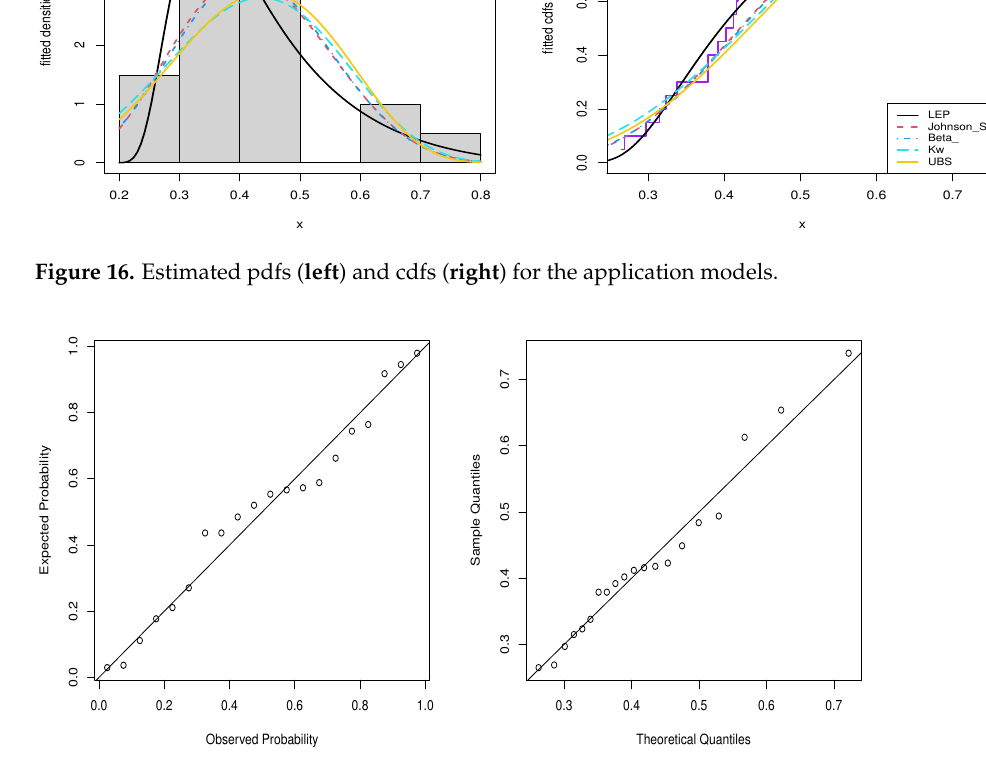
Figure 17. The PP ( left ) and QQ plots ( right ) of the LEP distribution for the fitted model. The profile log-likelihood (PLL) functions are plotted in Figure 18 for the parameters of the QLEP distribution. According to Figure 18, the estimated parameters are maximizers of the function in (13).